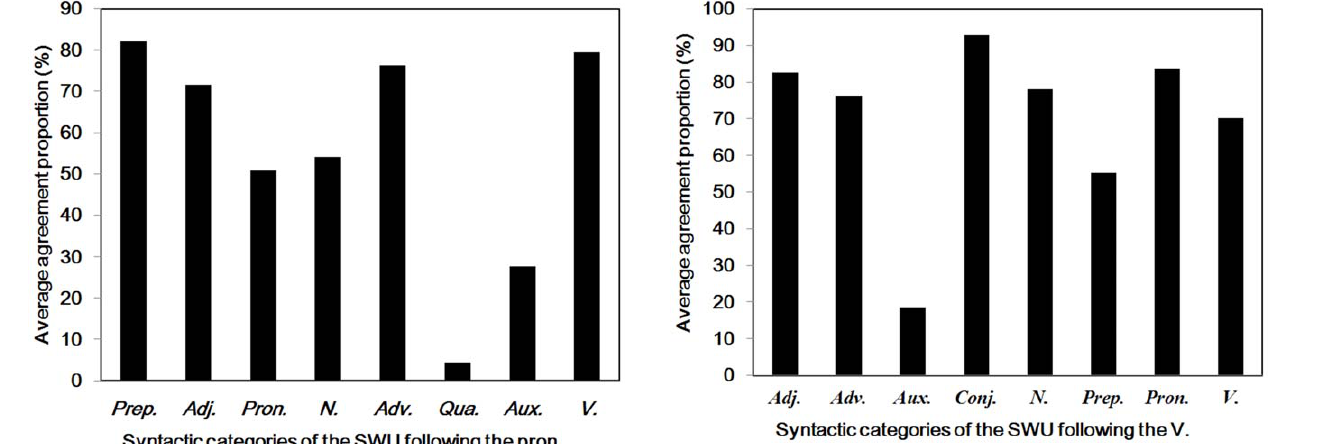
Figure 14. Pronouns and subsequent words. Average agreement proportions for word boundaries between the pronouns and different subsequent syntactic categories of SWU. Prep.=prepositions; Adj.=ad- jectives; Pron.=pronouns; N.=nouns; Adv.=adverbs; Qua.=quantifiers; Aux.=auxiliary words; V.=verbs.